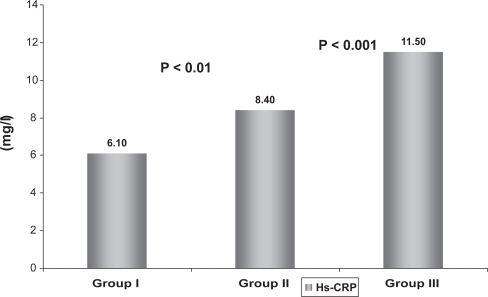
Comparison of Hs-CRP between different age groups.